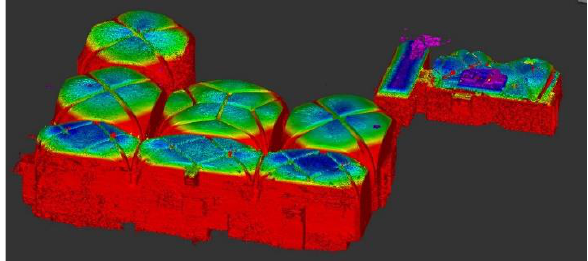
Figure 12. Analysis of the geometric deformation of the vaults in the lower floor.